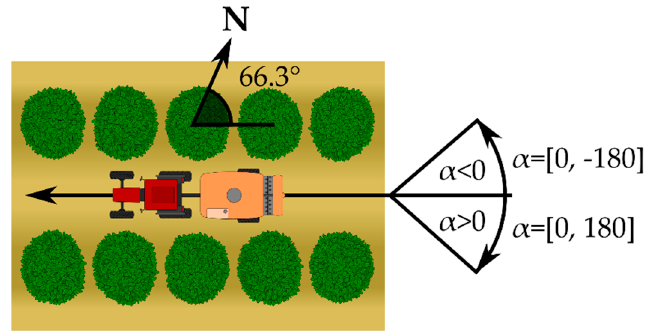
Figure 4. Criterion followed to determine wind direction with respect to tree rows. ‘N’ means geographic north. Angle α refers to the angle used to express the wind direction in the treatments.